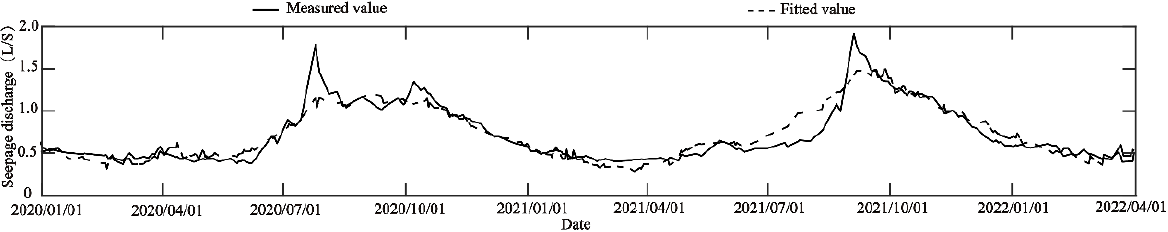
Figure 6. Fitting process line of seepage discharge at measuring point WE01YXD.